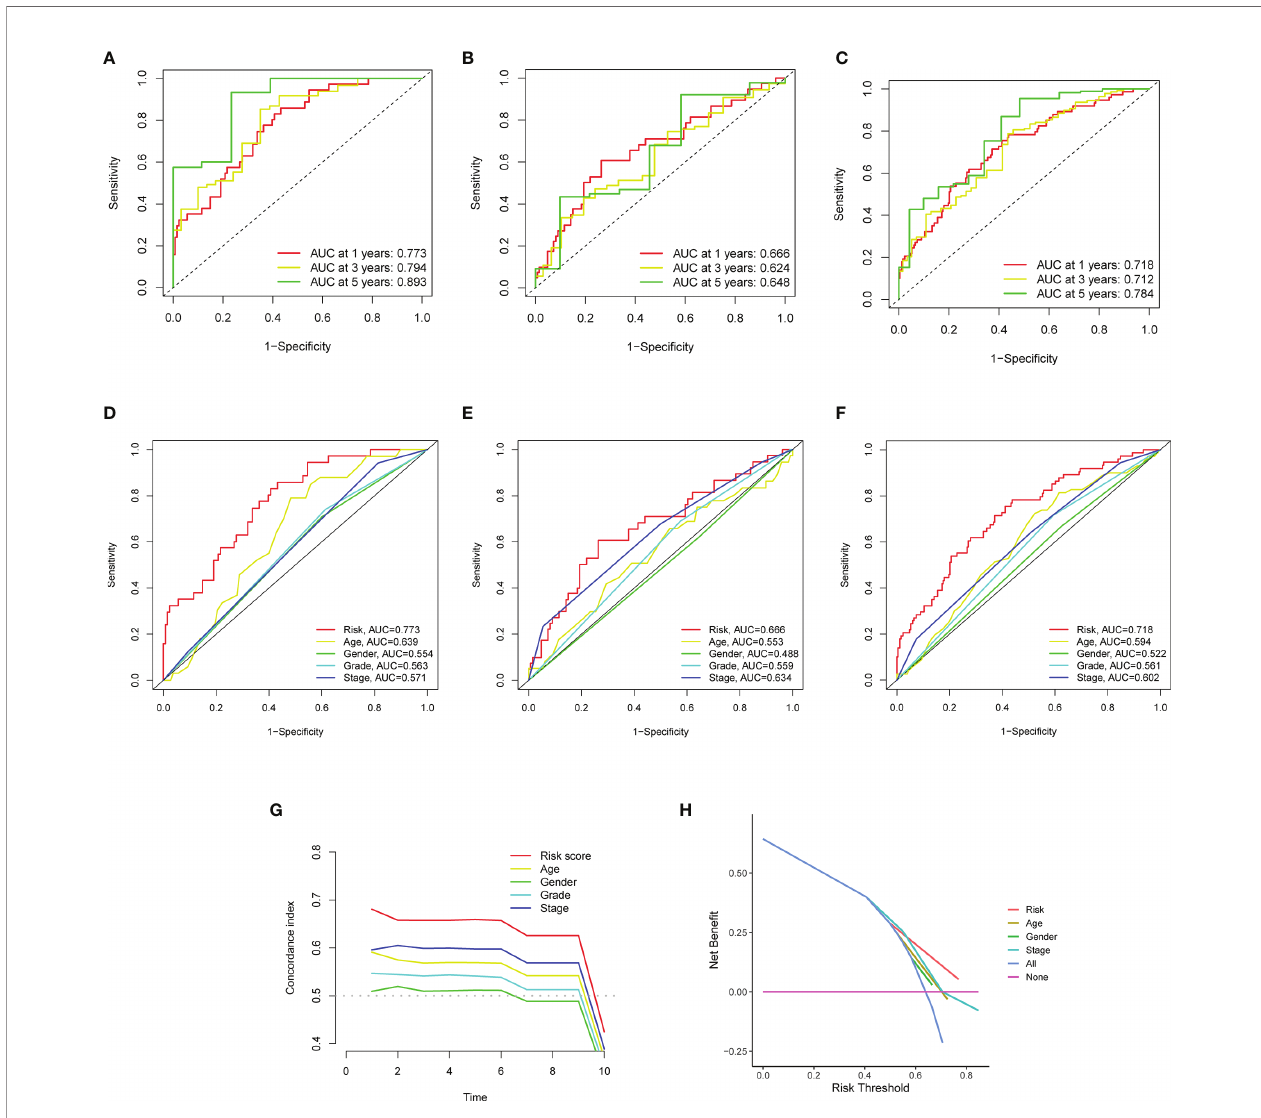
FIGURE 6 | The performance of the matrisomal-related lncRNAs in prognostic prediction. (A – C) Time-dependent ROC analysis for evaluating the sensitivity and speci fi city of this prognostic model in the training (A) , validation (B) , and total sets (C) . (D – F) Comparison of clinicopathological features and the risk score in the training (D) , validation (E) , and total sets (F) . (G, H) Comparison of clinicopathological features and the risk score in the total sets based on concordance index (G) and decision curve analysis (H)